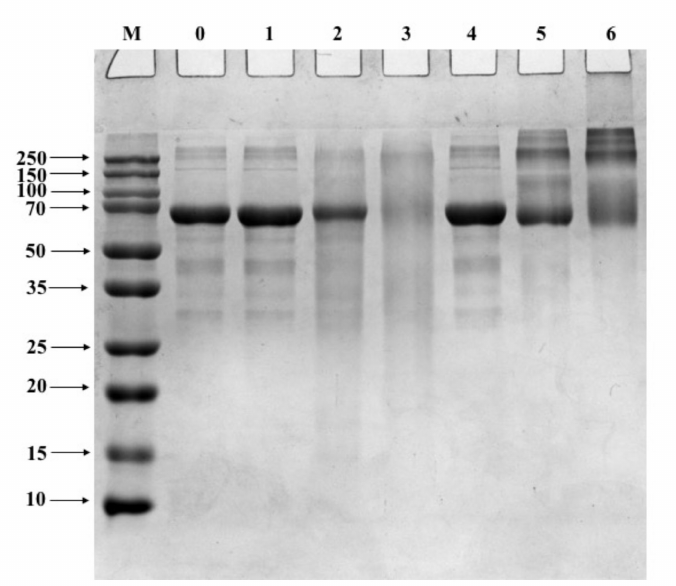
Figure 1. SDS-PAGE analysis of AAPH-CA and acrolein-CA. An equal amount of CA (5 µ g) was loaded to each lane. The molecular mass of the standard protein marker ranged from 10 to 250 kDa. Lane M, protein marker; Lane 0, native CA; Lanes 1–3, AAPH concentrations 1, 5, and 25 mmol/L, respectively; Lanes 4–6, acrolein concentrations 0.1, 1, and 10 mmol/L, respectively.